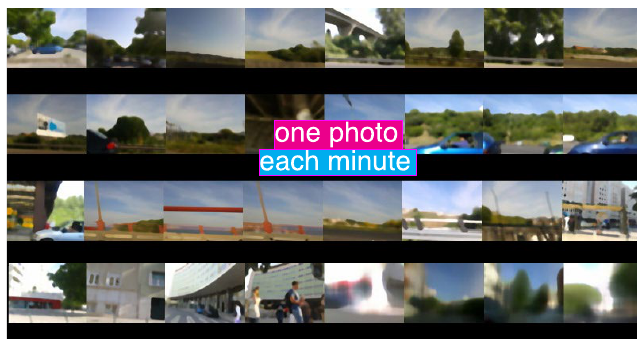
Fig. 3. Prototyping: taking one photo each